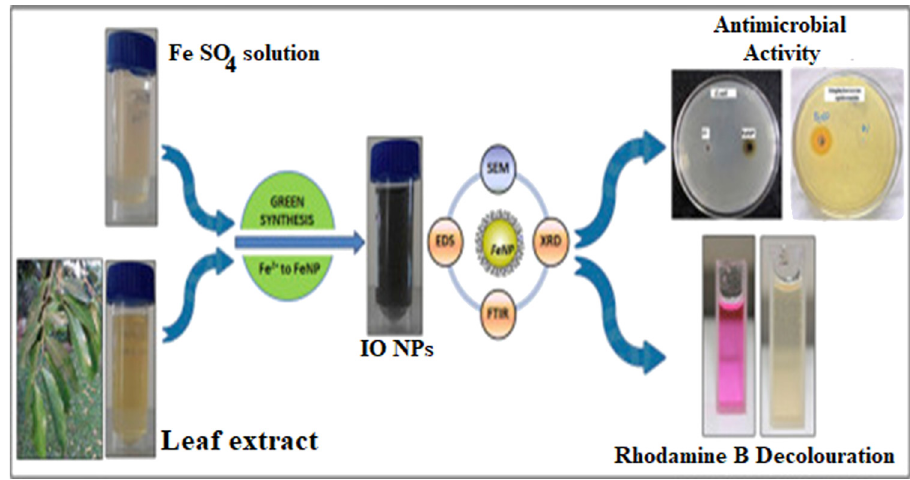
Figure 9: Biosynthesis of IO NPs using Cynometra rami fl ora leaf extract for biomedical and environmental